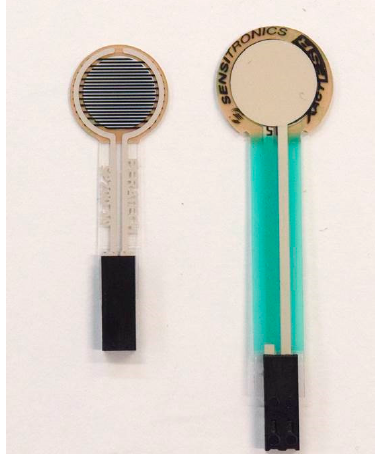
Figure 1. Piezoresistive force sensors used for evaluation: ( left ) Peratech QTC™; ( right ) Sensitronics ® FSR.